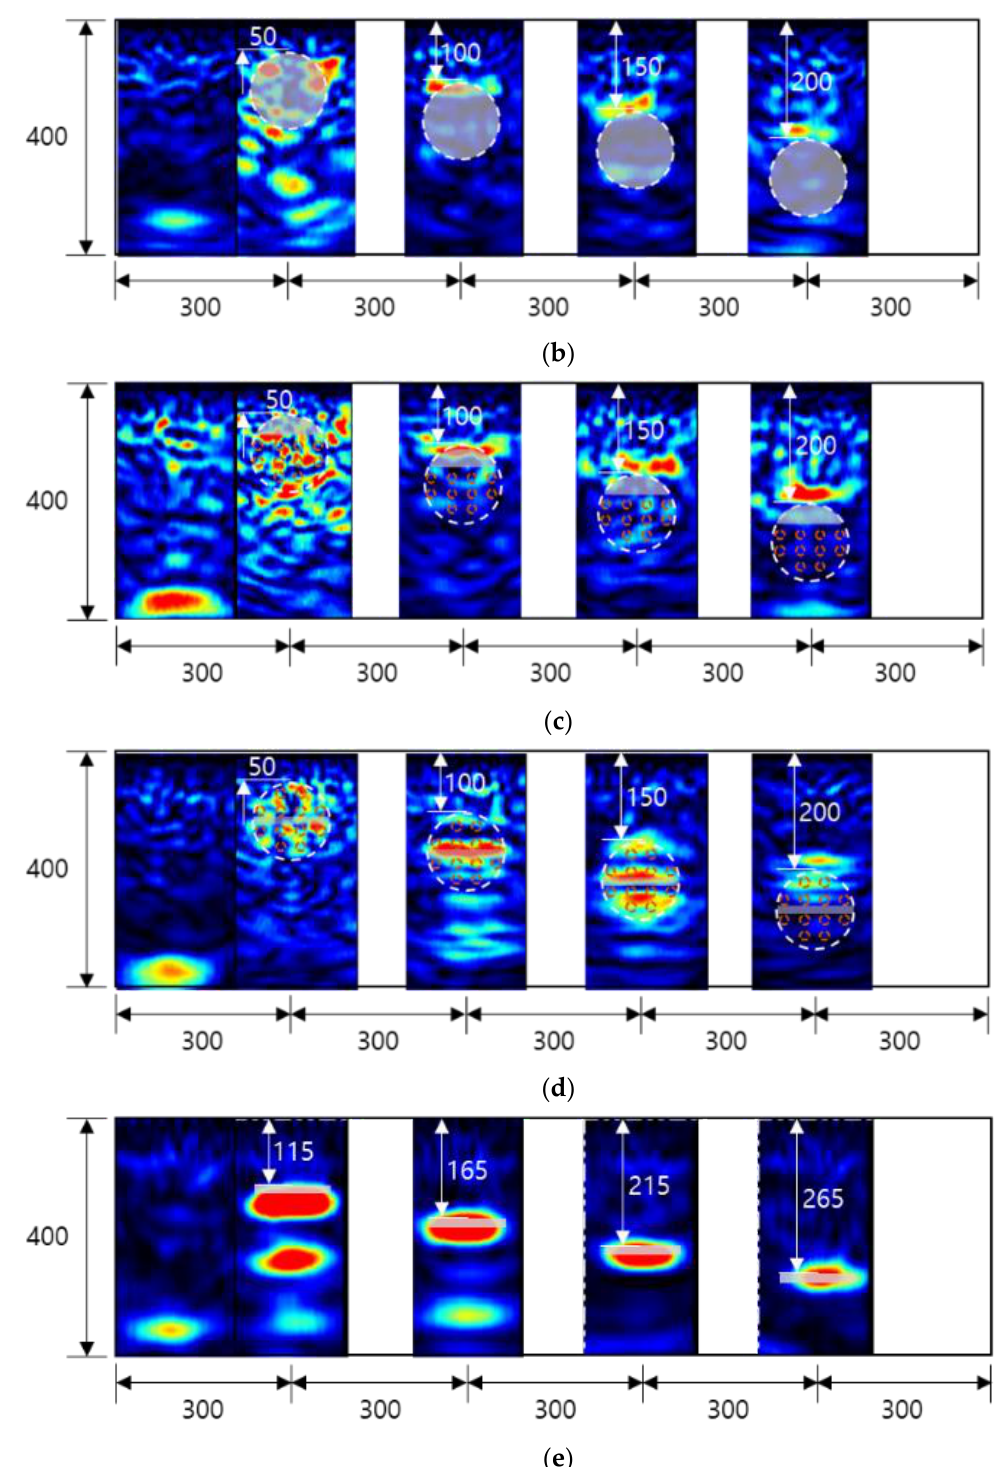
Figure 10. B scan results by Pundit 250 array. Slabs: ( a ) A; ( b ) B; ( c ) C; ( d ) D; ( e ) E (dimensions in mm).